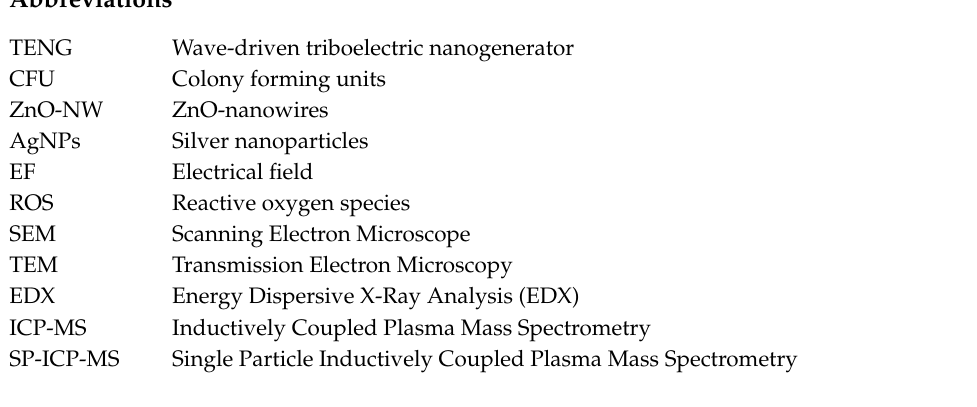
Figure S1: Image analysis of filtered fragments by the light microscopy, Figure S2: Released Ag nanoparticles from carbon clothes, Figure S3: Size distribution of released Ag nanoparticles from carbon cloth in 5 days’ simulation of release, Figure S4: Compare di ff erent analysis methods to analyse the released ZnO-NW / dissolved Zn and / or AgNP / dissolved Ag from the carbon cloth in a 5 day simulation, Figure S5: The output of statistical analysis to released